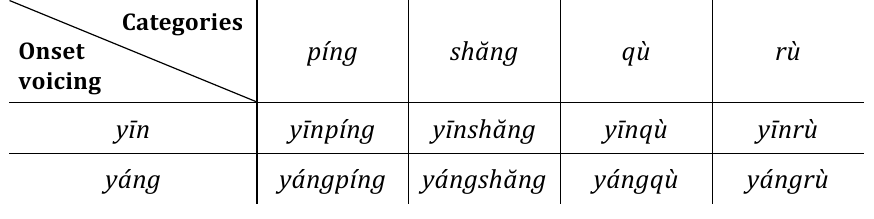
Table 1: Eight tones in Chinese historical